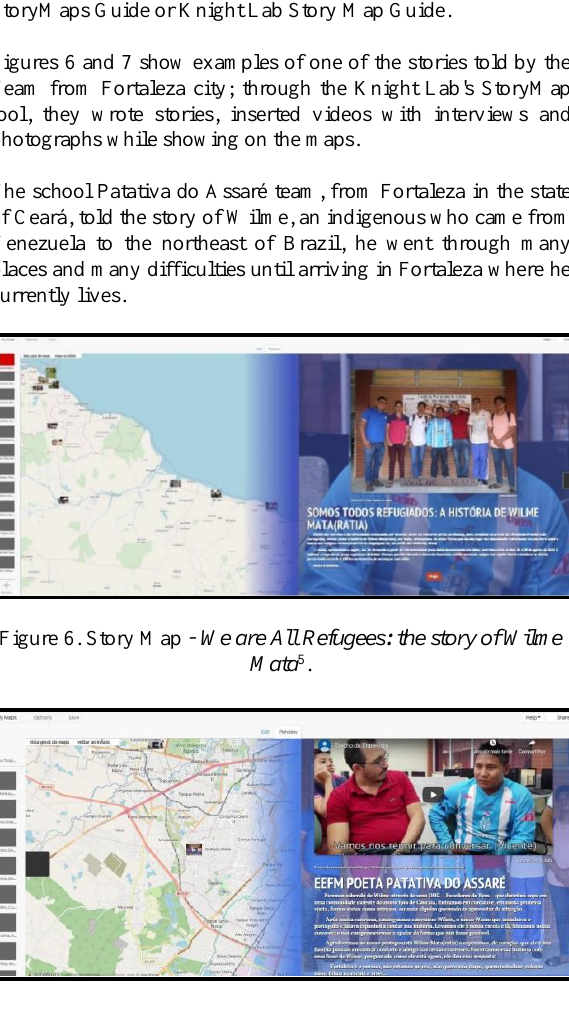
Figure 7. Story Map - We are All Refugees: the story of Wilme Mata, the interview with